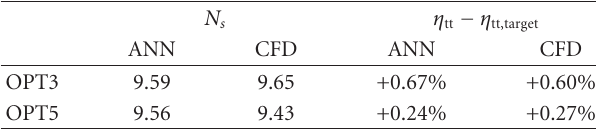
Table 4: Comparison between pump performance predicted by ANN and calculated with